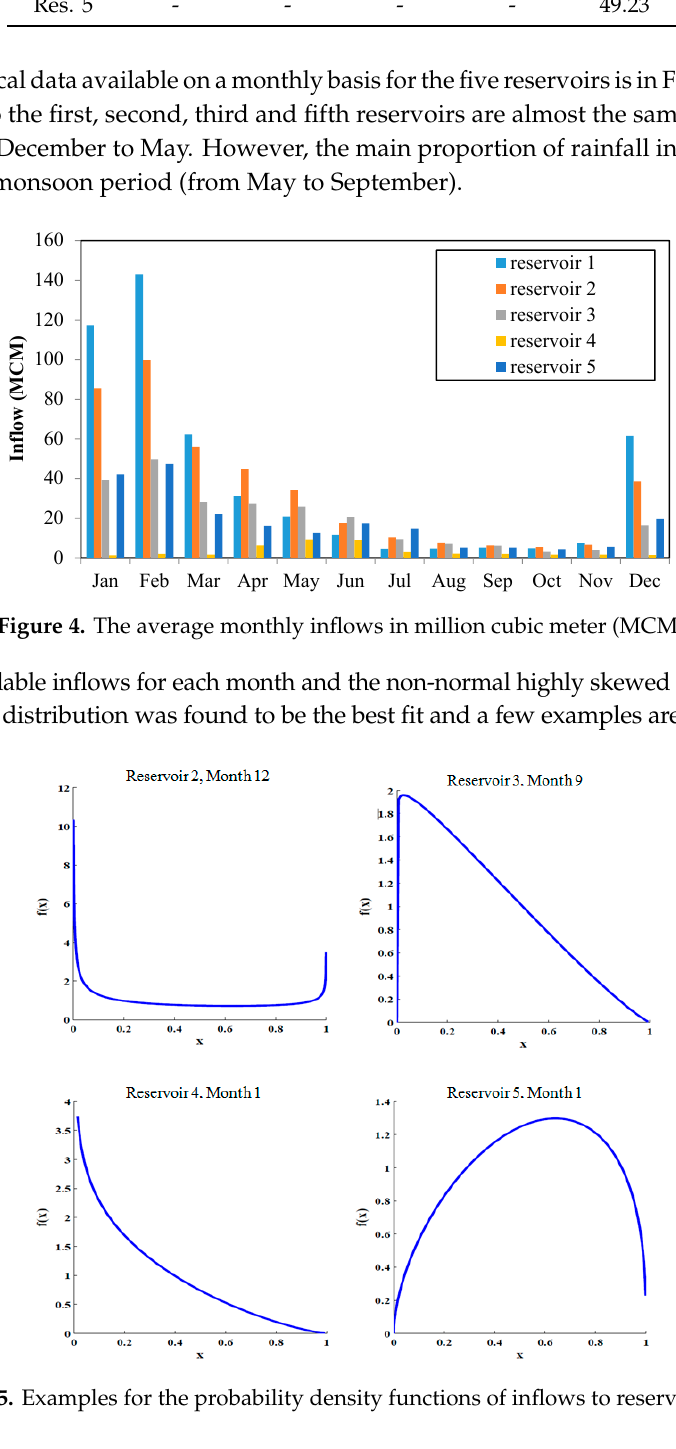
Table 2. The upper bounds of release.